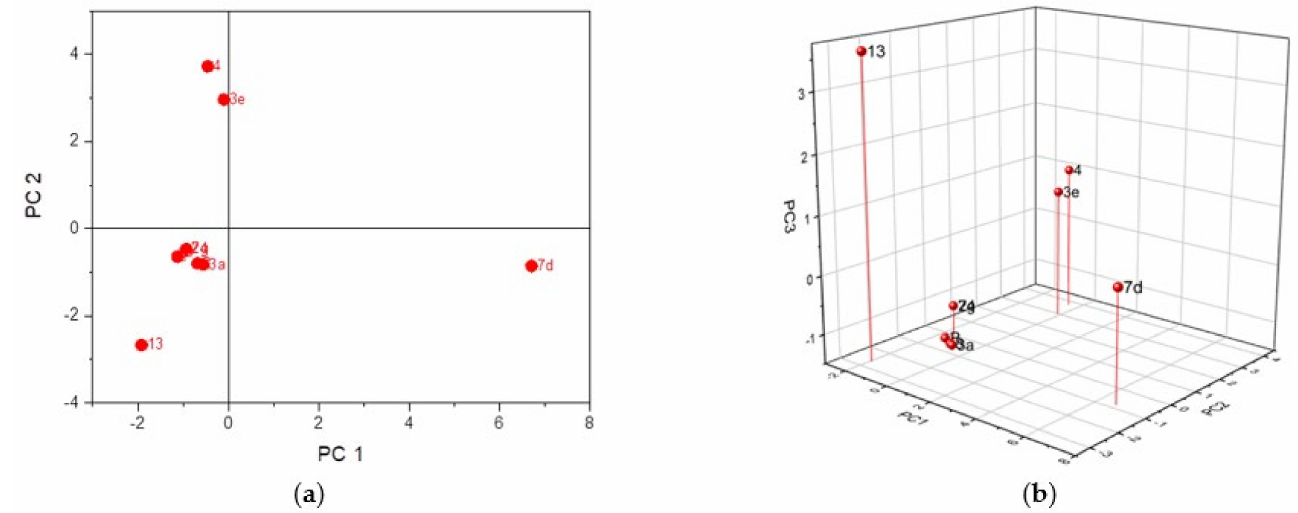
Figure 6. ( a ) PCA for double PFs: 16 PFs (SD > 30); ( b ) percentage of variance explained by PC1 41%, PC2 26% and PC3 17% (cumulative of variance